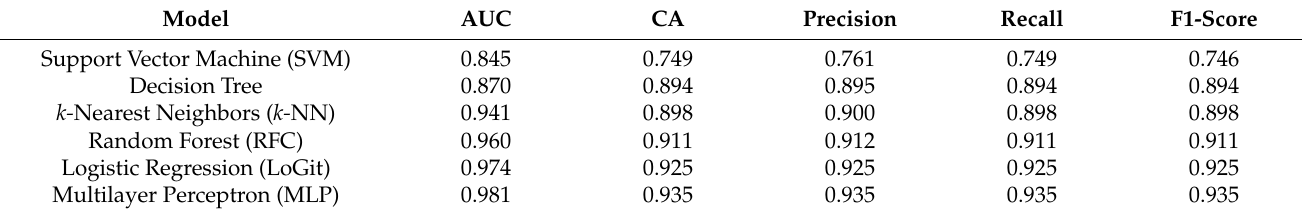
Table 2. Performance metrics from classification algorithms initially evaluated.